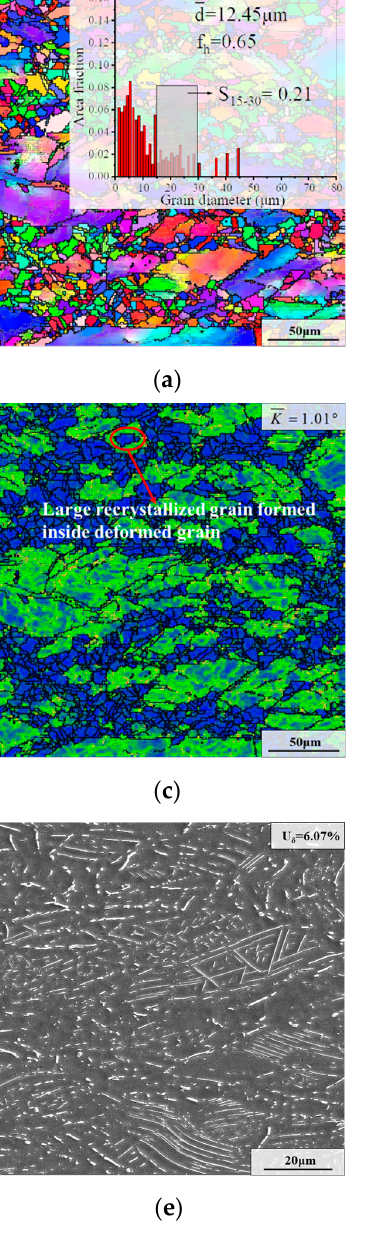
Figure 11. Microstructures after the second annealing stage with various strain rates of: ( a , c , e ) 0.001 s − 1 ; ( b , d , f ) 0.01 s − 1 . (The deformation temperature was 950 °C, and the true strain was 0.69. S 15–30 represents the cumulative value of the area fraction of average grain size in the range of 15–30 μ m).